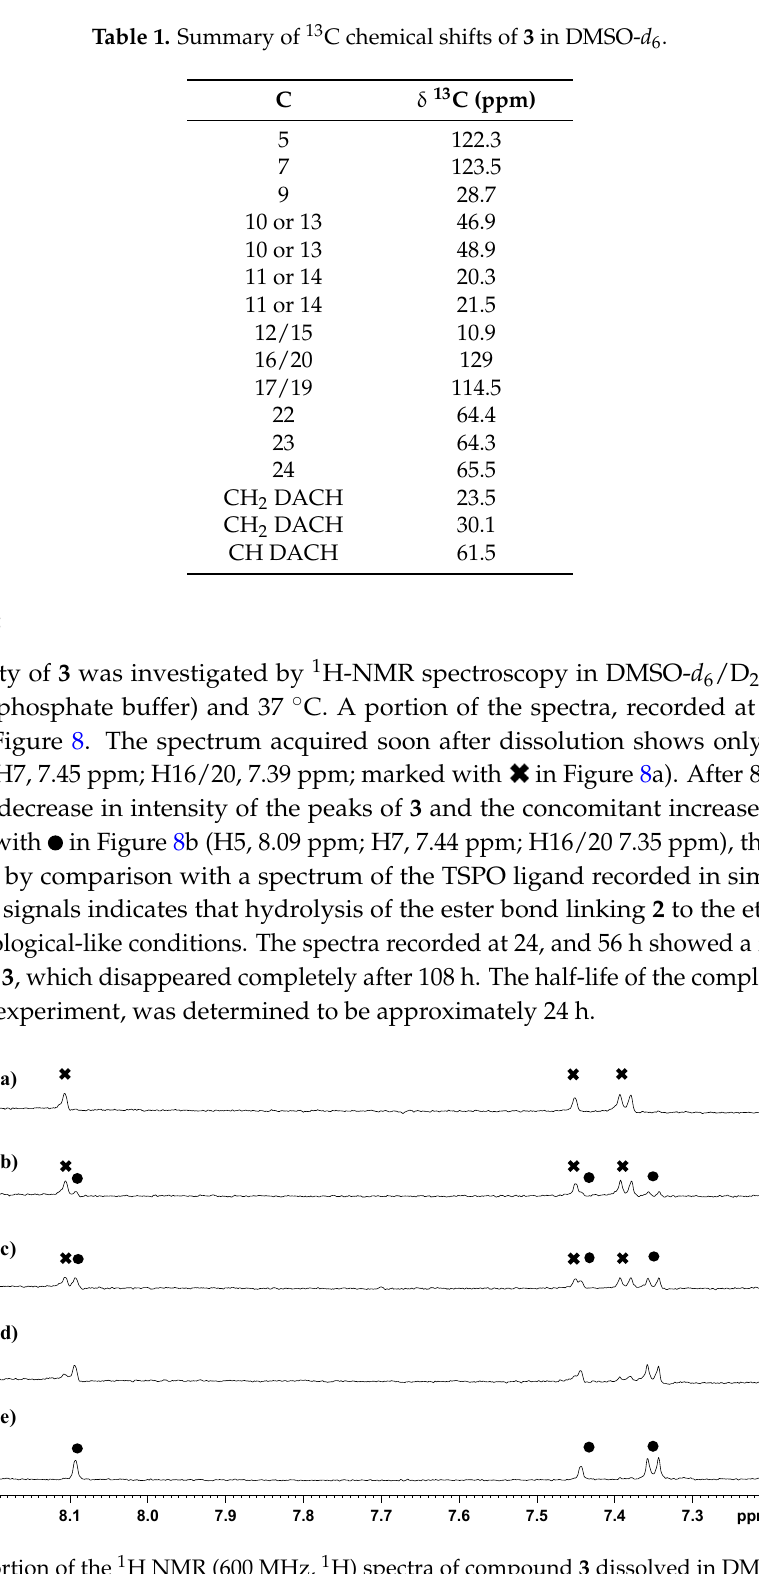
Figure 8. Portion of the 1 H NMR (600 MHz, 1 H) spectra of compound 3 dissolved in DMSO-d 6 /D 2 O (5:95 v / v ) and incubated at pH 7.4 (2 mM phosphate buffer) and 37 °C. Spectra were recorded at zero time ( a ) and after 8 ( b ); 24 ( c ); 56 ( d ); and 108 h ( e ). indicates peaks relevant to the portion of TSPO ligand in complex 3 . ● indicates peaks of free TSPO ligand ( 2 ). The amine protons were deuterated due to the fast H/D exchange.